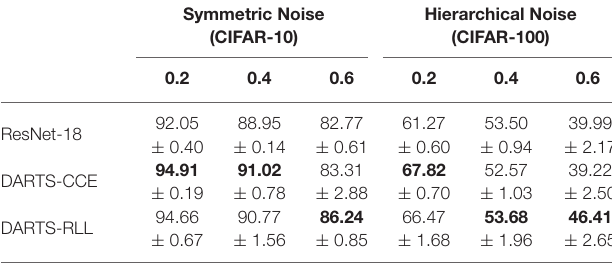
TABLE 3 | NAS with